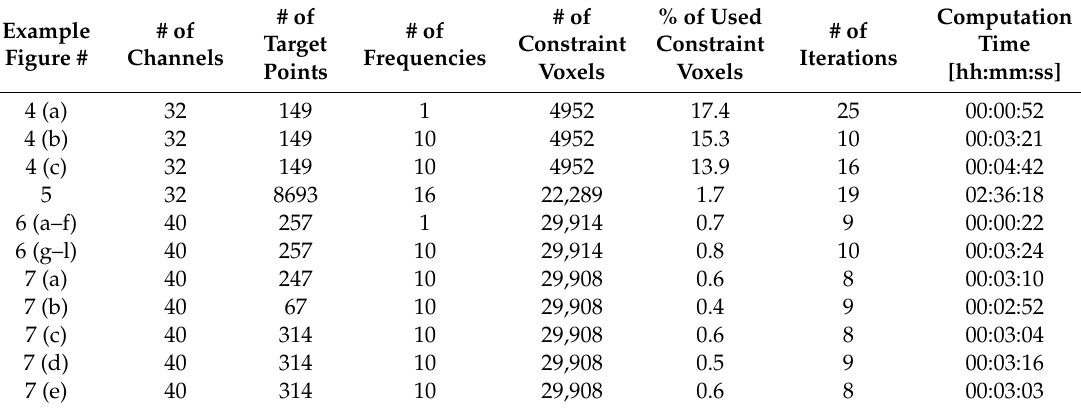
Table 1. Overview of the problem size and required computational time for all